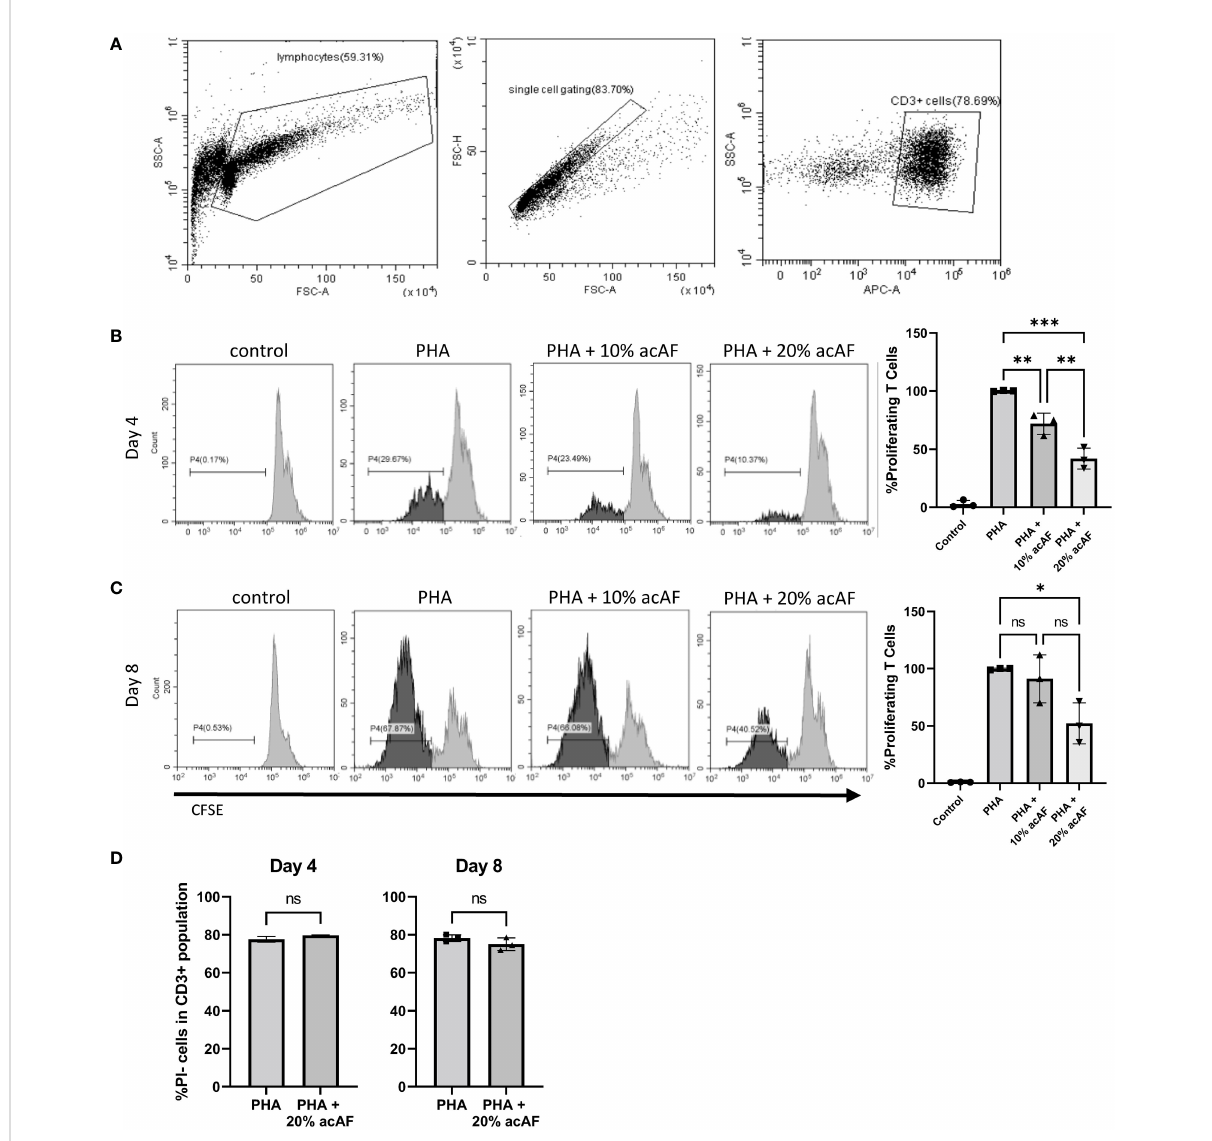
FIGURE 1 AcAF Attenuates T Cell Proliferation 4 and 8 days after PHA Stimulation (A) Representative fl ow cytometry CD3+ gating. Representative histograms of proliferating CD3+ T cells in each group and graphed as percentages of the PHA vehicle control group following (B) 4-day PHA stimulation or (C) 8-day PHA stimulation. (D) Graphed percentages of PI- cells within CD3+ population. (Data graphed as mean ± SD; One way ANOVA with Tukey ’ s test; n=3 for each group; *=p<.05; **=p<.01; ***=p<.001; ns=not signi fi cant; Data is derived from 3 separate experiments. Each experiment used 1 independent PBMC donor treated with 1 of 3 acAF